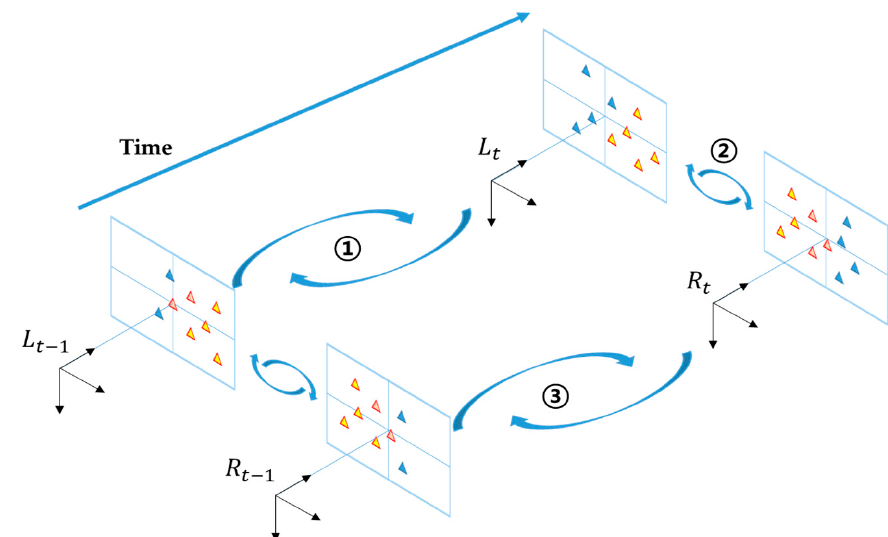
Figure 5. Corresponding point verification concept diagram.